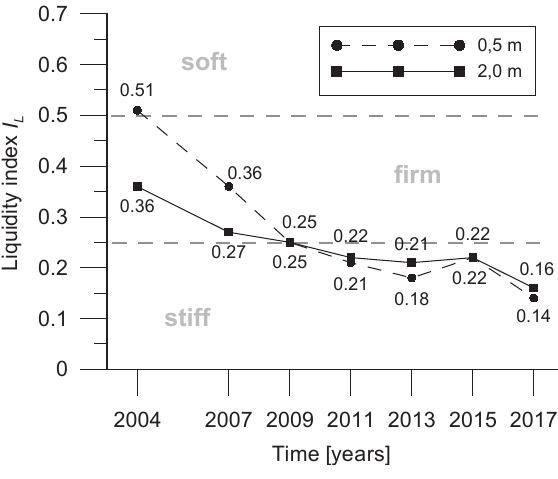
Fig. 8. Changes of the retaining embankment soil liquidity index (mean values from three boreholes) Figure 8 : Changes in the retaining embankment soil liquidity index (mean values from three